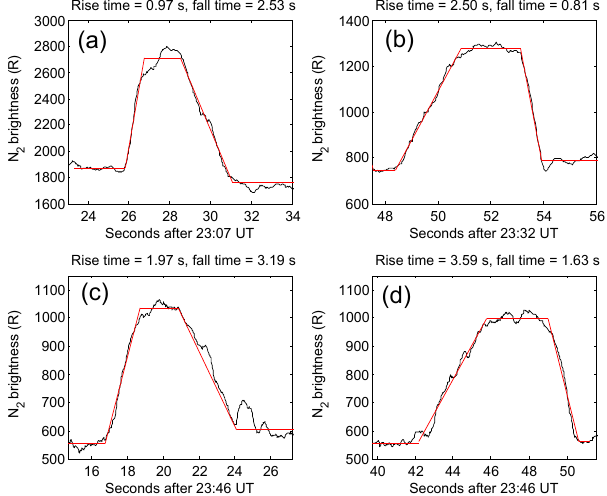
Figure 10. Auroral pulsations observed on 19 January 2007, with asymmetric appearance. In (a, c) the fall time of brightness is much longer than the rise time, and in (b, d) the opposite is true. The horizontal red lines show the mean brightness level and the sloped line shows the linear fit to the rise and fall used to estimate the